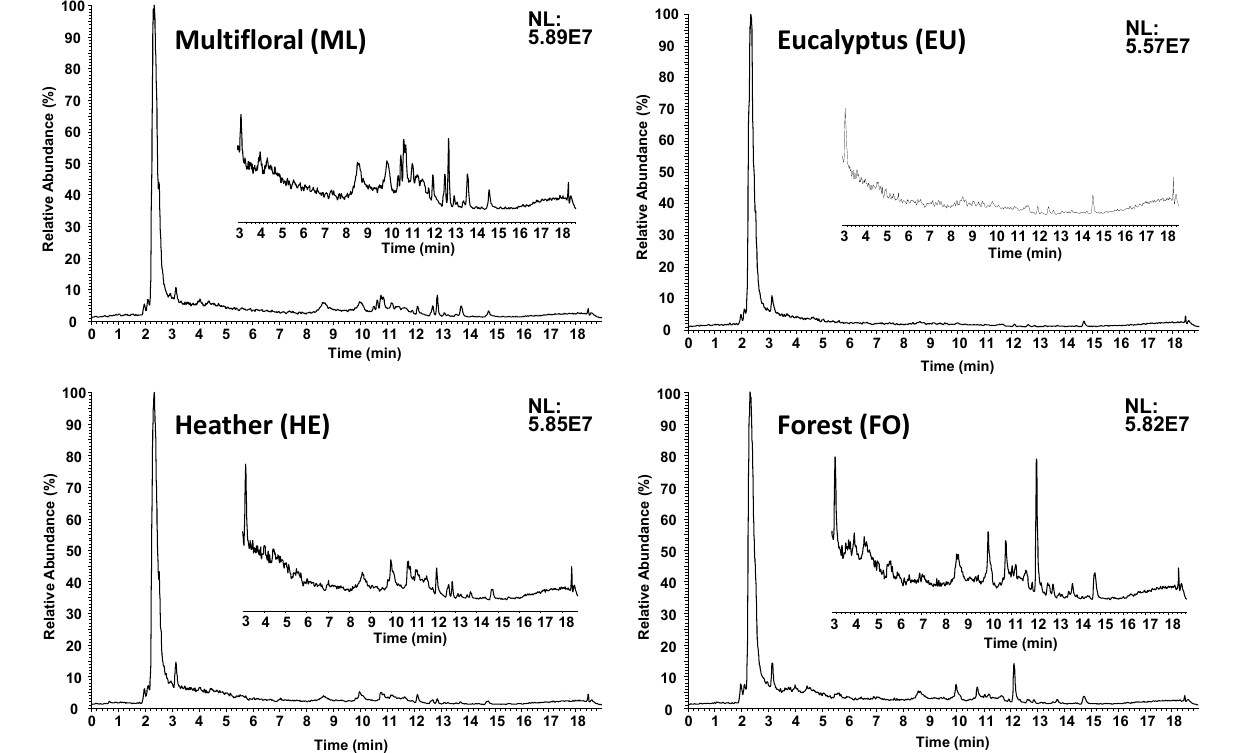
Figure 1. Non-targeted LC–HRMS (total ion chromatogram) fingerprints obtained for multifloral, eucalyptus, heather and forest honeys.